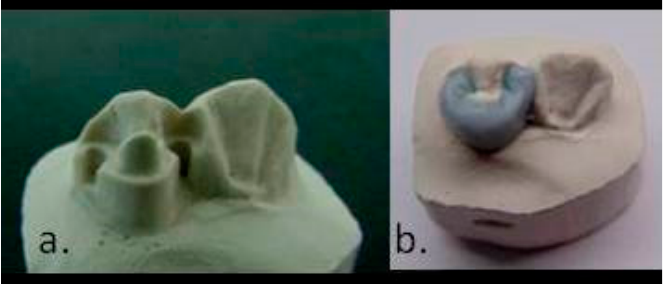
Figure 7. ( a ). The refractory duplicate of the Pa framework; ( b ). Making the model for the comple- mentary framework Pb.